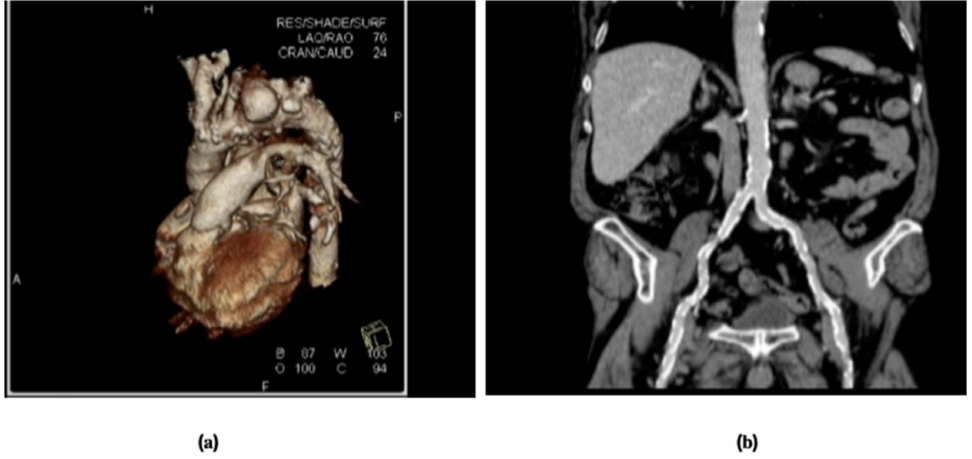
Figure 3. Pre-operative CT-scan: ( a ) 3D reconstruction of distal arch pseudo aneurysms due to penetrating aortic ulcers; ( b ) coronal view showing severe calcific occlusive disease of infra-renal aorta and peripheral